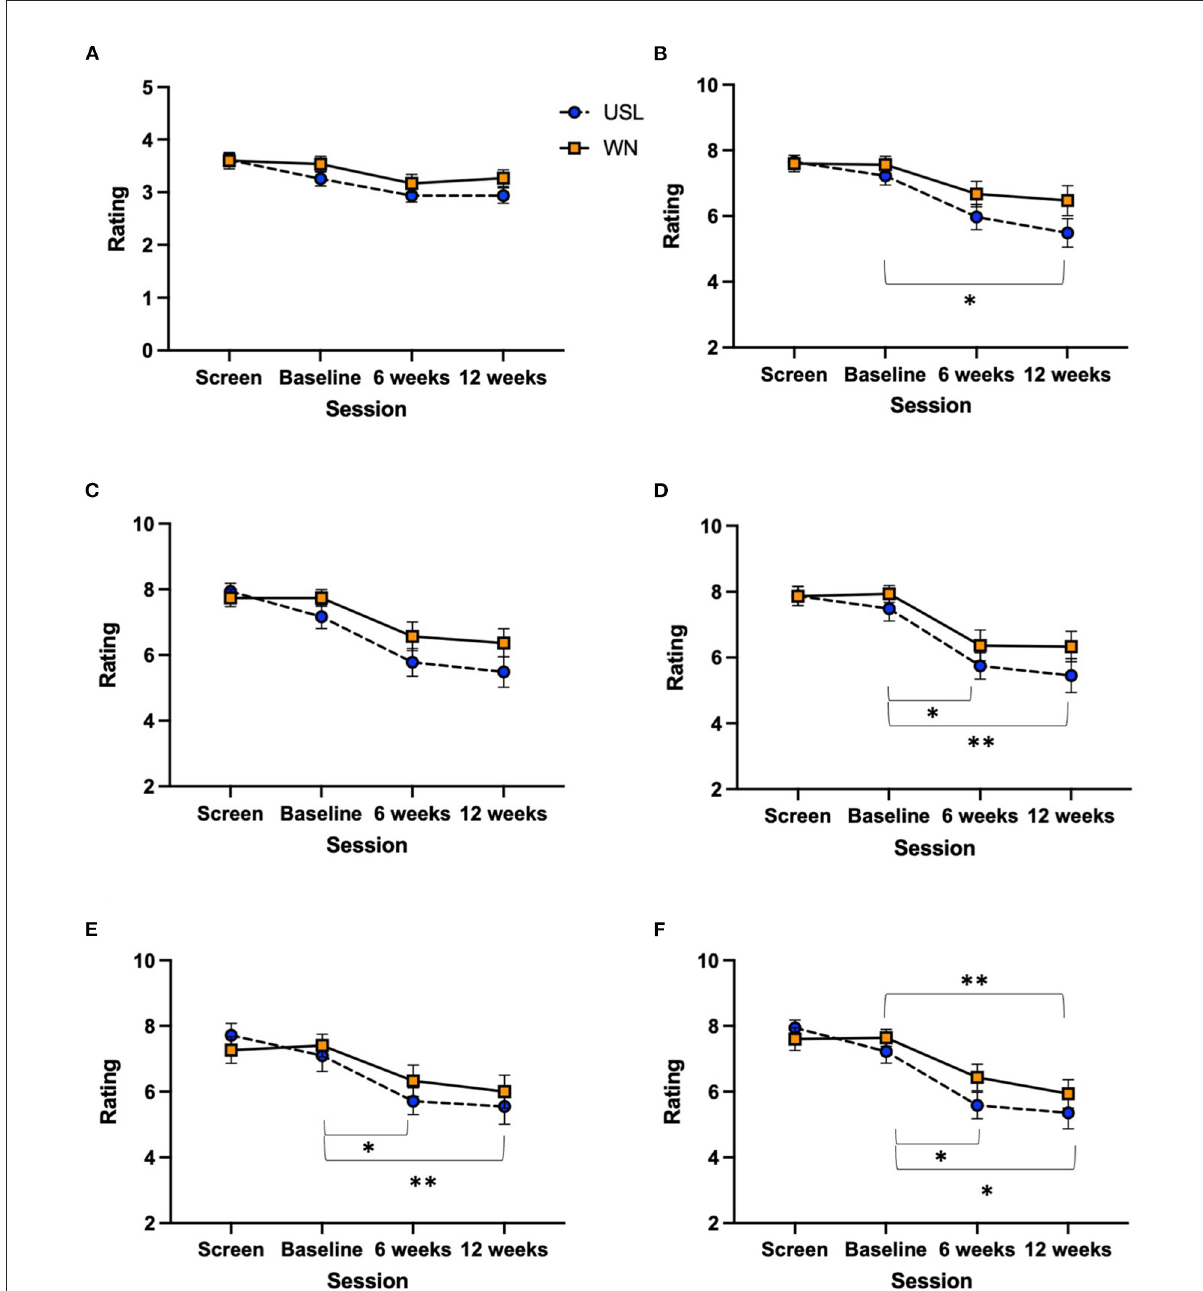
FIGURE7 Rating scales scores across sessions. (A) Problem, (B) strong, (C) uncomfortable, (D) annoyance, (E) ignore, and (F) unpleasant. USL group (dashed line) WN group (solid line) ( * P < 0.05, ** P < 0.01). For consistency with other figures mean and standard error scores are shown, the non-parametric statistics shown are based on